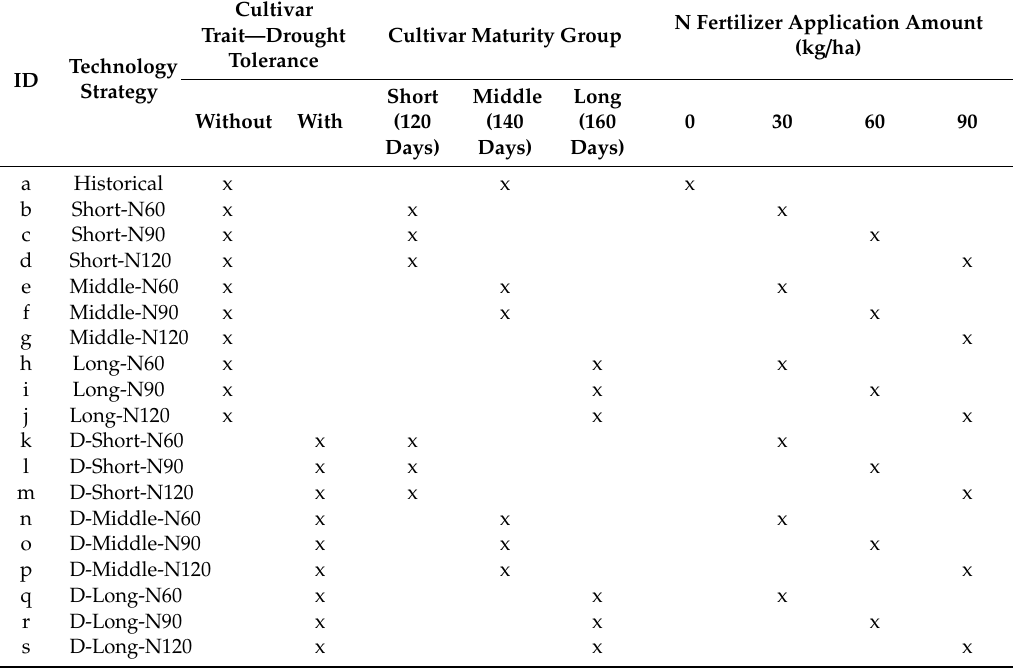
Table 1. Technology strategies that could be adopted by smallholder